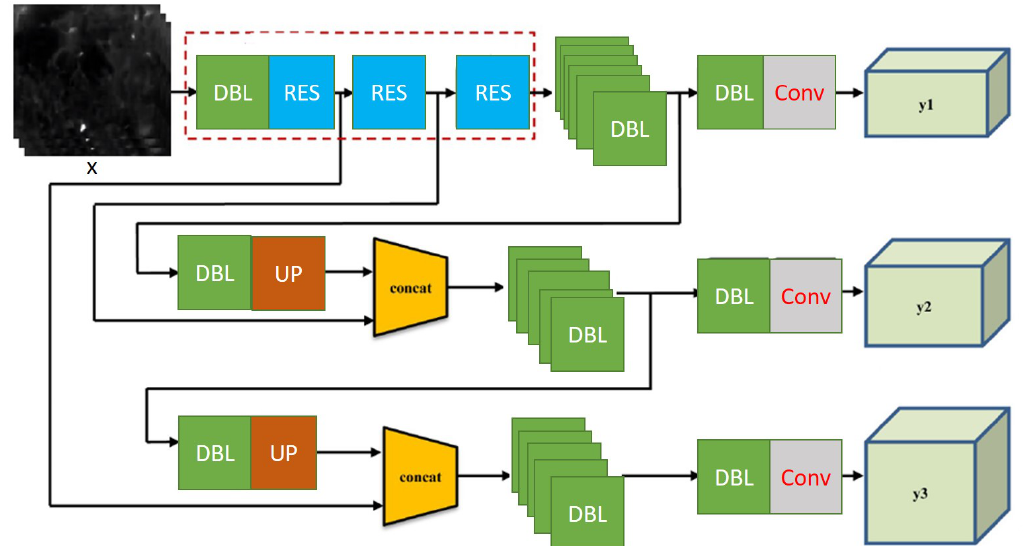
Figure 4. YOLOv3 architecture with the input image and three types of feature map as output. The basic element of YOLOv3 is called Darknet conv2D BN Leaky (DBL), which is composed of one convolution layer, one batch normalization layer, and one leaky relu layer. Other important components of the structure are explained in the